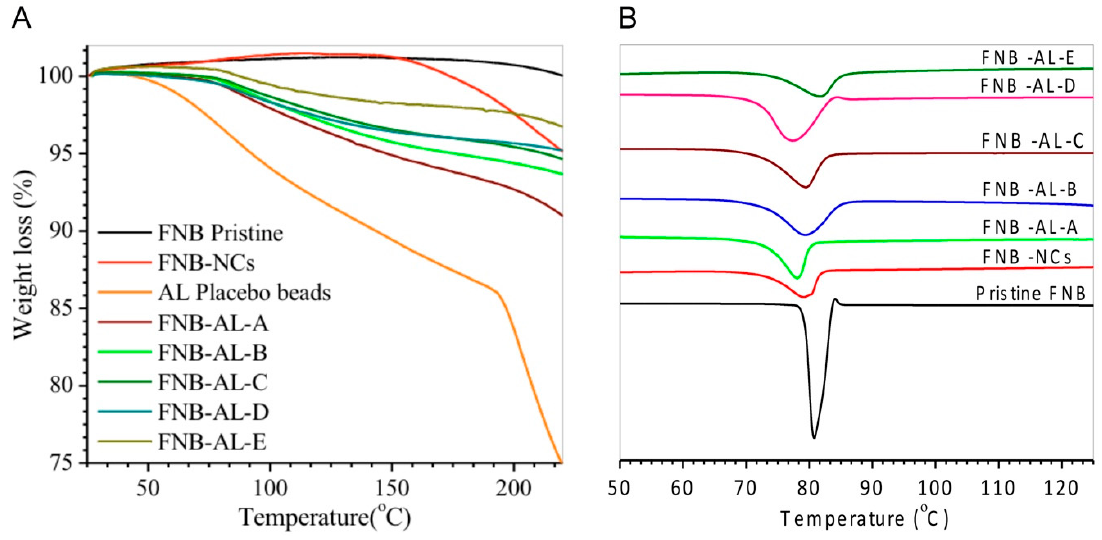
Figure 5. ( A ) Thermogravimetric analysis (TGA) and ( B ) differential scanning calorimetry (DSC) patterns.